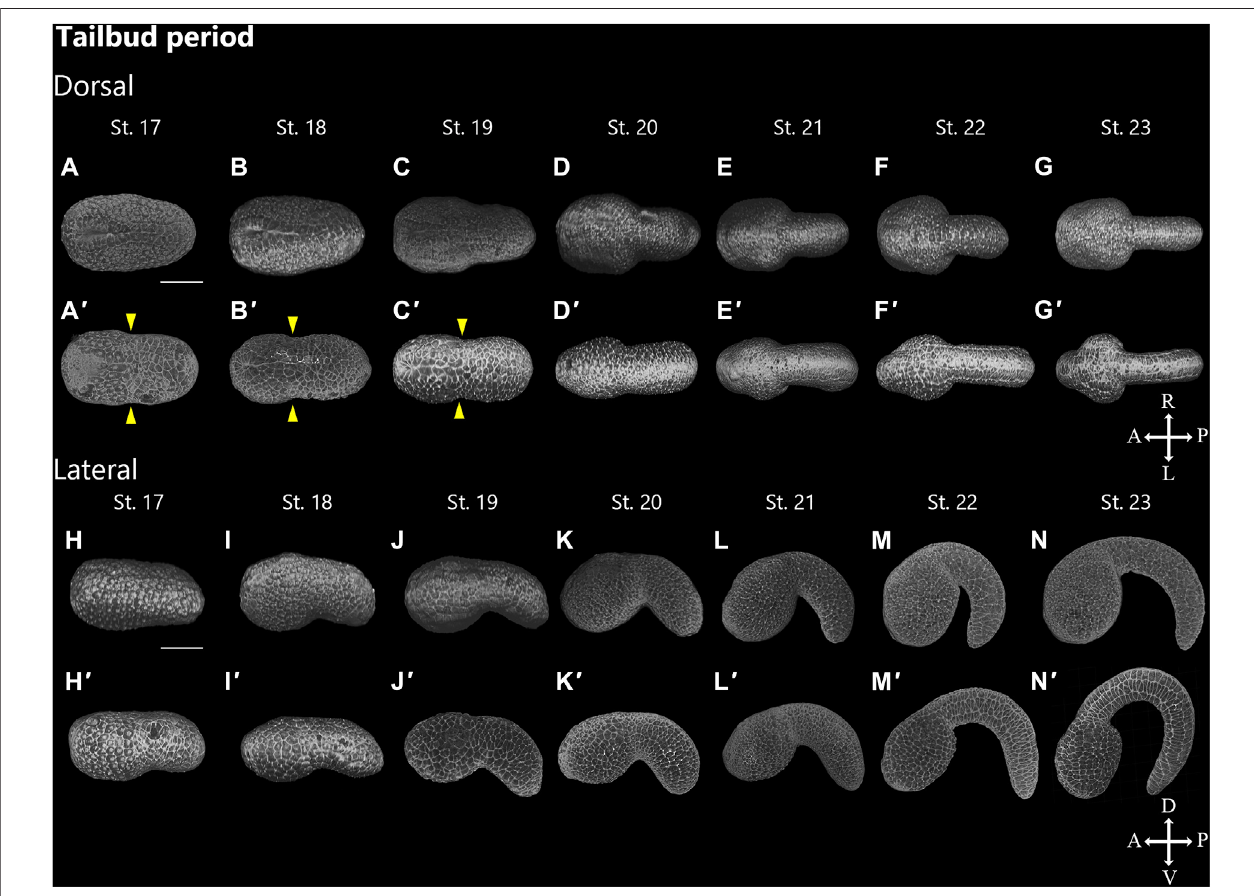
FIGURE10| ComparisonoftailbendingandKUBIREattailbudperiodandlarvalmorphologybetween A . aspersa and C . intestinalis .Dorsalviewsofthe A . aspersa embryos (A – G) and the C . intestinalis embryos (A 9 – G 9 ) at Stage 17 – 23. Lateral views ofthe A . aspersa embryos (H – N) and the C . intestinalis embryos (H 9 – N 9 ) at Stage 17 – 23. Larval morphology of A . aspersa (O – S) and C . intestinalis (O 9 – S 9 ) at Stage 26. Embryo direction is shown by A, anterior; P, posterior; D, dorsal; V, ventral. Arrowheads indicate hour-grass shaped KUBIRE. Asterisks indicates the papillae by *l: left papilla, *r: right papilla, *v: ventral papilla. asp, atrial siphon primordium; epi, epidermis; gp, gut primordium; mech, mesenchyme; nhd, neurohypophyseal duct; noto, notochord; osp, oral siphon primordium; pl, preoral lobe; SV, sensory vesicle; va, vacuole; and vg, visceral ganglion. Scale bar: 50 μ m.